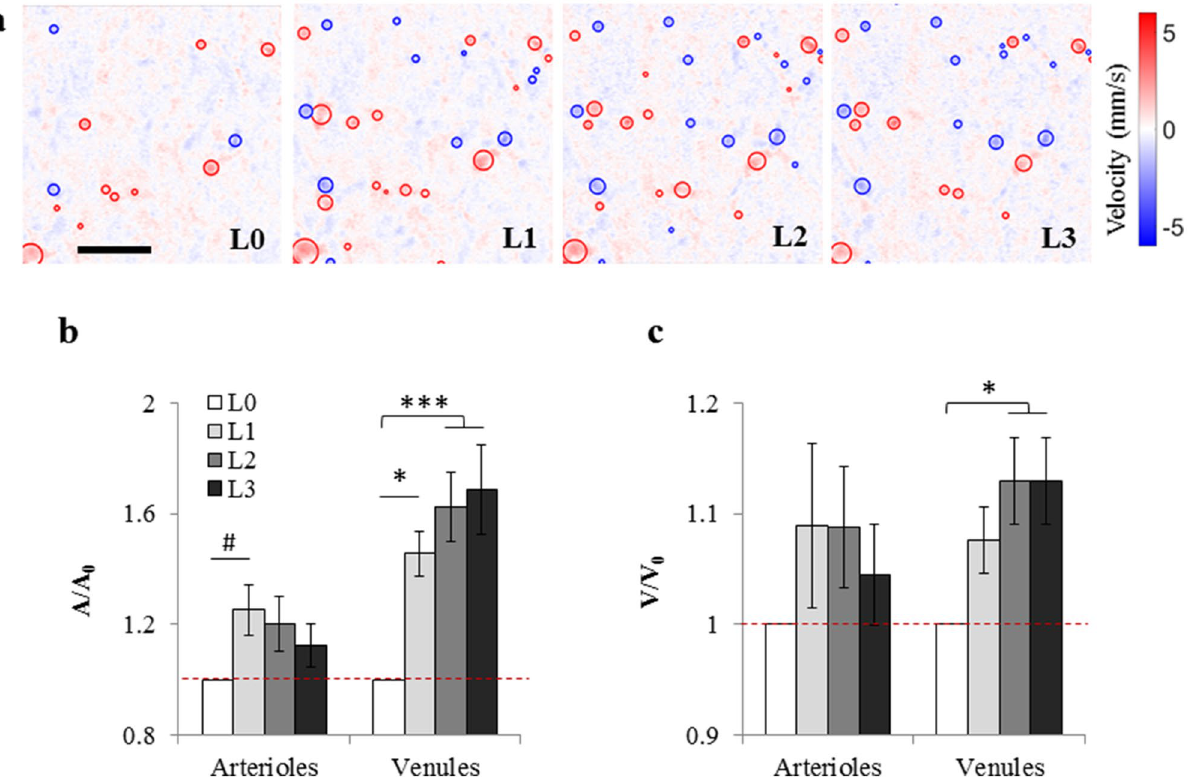
Figure 3. Non-capillary blood flow. (a) Representative en face slices through the OCT Doppler-velocity volume at a cortical depth of approximately 100 μm for exercise levels L0 to L3. The scale bar is 200 µm. Positive velocity (red) represents downward flow (arterioles) and negative velocity (blue) represents upward flow (venules). For each slice in the OCT velocity volume, arterioles and venules were detected (red and blue circles) and their area and average velocity were obtained. Same vessels were identified on OCT velocity volumes from different exercise levels and the variation of these parameters with the exercise level was quantified. (b, c) Average vessel cross-sectional area (b) and blood velocity (c) of individual arterioles and venules. For each vessel, parameters were normalized to the values at rest. The dashed lines represent the rest (arterioles: n = 23 vessels; venules: n = 22 vessels). L0: rest, L1: exercise level 1 (5 m/min), L2: exercise level 2 (10 m/min), L3: exercise level 3 (15 m/ min). Bar plots represent mean ± s.e.m. Statistical significance was calculated using ANOVA followed by Tukey HSD post hoc test. ***p < 0.001, *p < 0.05, # p-value approaches significance (p <